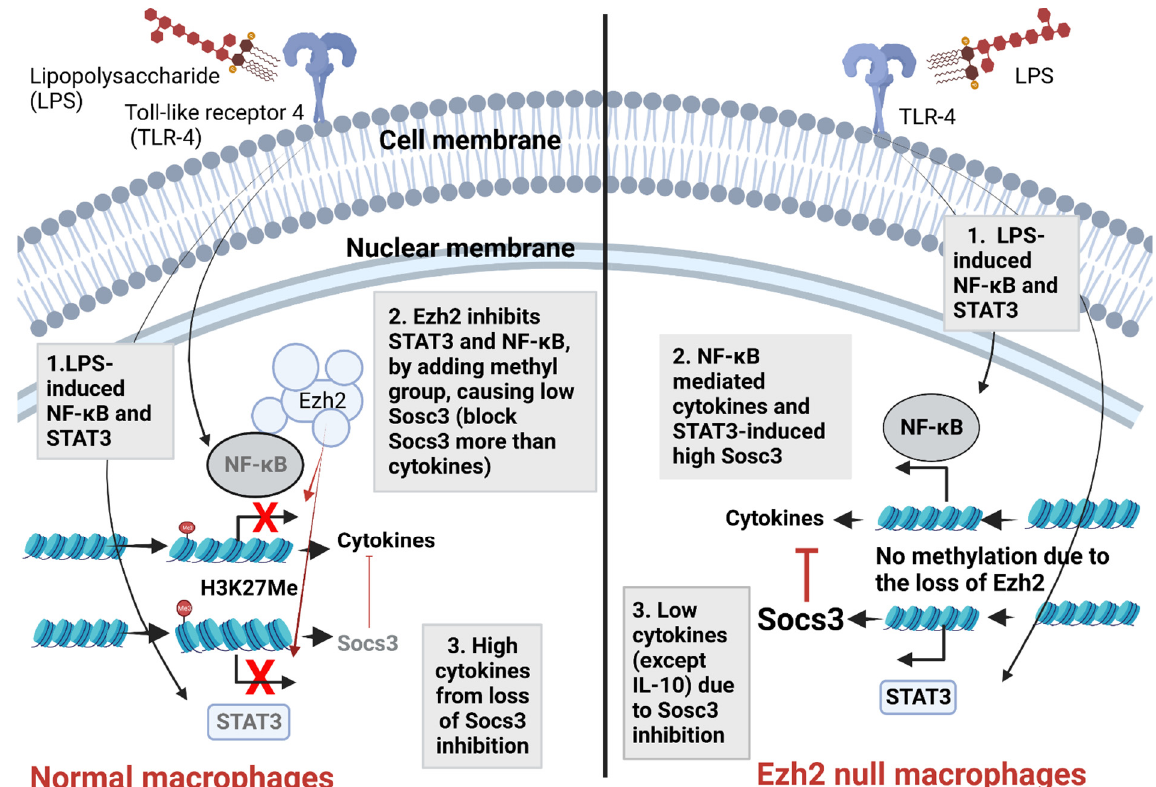
Figure 6. The proposed working hypothesis demonstrates the impact of Ezh2 (Enhancer of zeste homolog 2) in response against lipopolysaccharide (LPS) of macrophages. In normal macrophages (left side), LPS recognition by Toll-like receptor 4 (TLR-4) initiates several downstream signals, including nuclear factor-kappa B (NF- κ B) and signal transducer and activator of transcription 3 (STAT3) [85] (number 1). The presence of Ezh2 causes the methylation on the 27th lysine of the histone (H3K27Me) resulting in the blockage of NF- κ B and STAT3, which reduces cytokine production and suppressor of cytokine signaling 3 (Socs3; the inhibitor of NF- κ B signaling [35,49]), respectively (number 2). The downregulated Sosc3 causes an increase in cytokines, highlighting the impact of the Ezh2 gene on the induction of LPS pro-inflammatory responses (number 3). Without Ezh2 (right side), both NF- κ B and STAT3 effectively transcribe DNA into RNA of cytokines and Sosc3 (number 2); the upregulated Socs3 inhibits the synthesis of pro-inflammatory cytokines (TNF- α and IL-6), but not anti-inflammatory cytokines (IL-10) (number 3). More experiments are needed for a solid conclusion. Picture created by